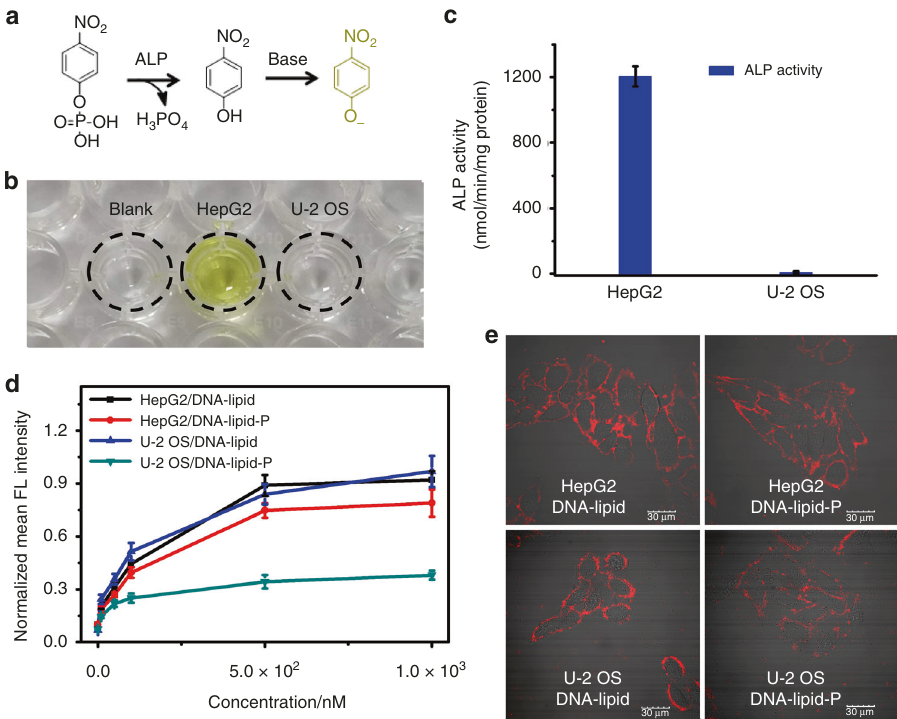
Fig. 6 Selective cell membrane anchorage of DNA-lipid-P. a The reaction equation and chromogenic mechanism of p -nitrophenyl phosphate in the measurement of ALP enzymatic activity. b Photograph of p -nitrophenyl phosphate before (blank) and after enzymatic dephosphorylation in cell lysis- containing buffer solution. c Calculated enzymatic activity of ALP in HepG2 and U-2 OS cells. Error bars indicate standard deviation. d The normalized mean fl uorescence intensity of HepG2 or U-2 OS cells treated with TAMRA-labeled DNA-lipid or DNA-lipid-P for one hour at 37 °C. Error bars indicate standard deviation. e Confocal fl uorescence microscopy imaging of HepG2 and U-2 OS cells treated with 1 μ M TAMRA-labeled DNA-lipid or DNA-lipid-P for one hour at 37 °C. Scale bar is 30 μ